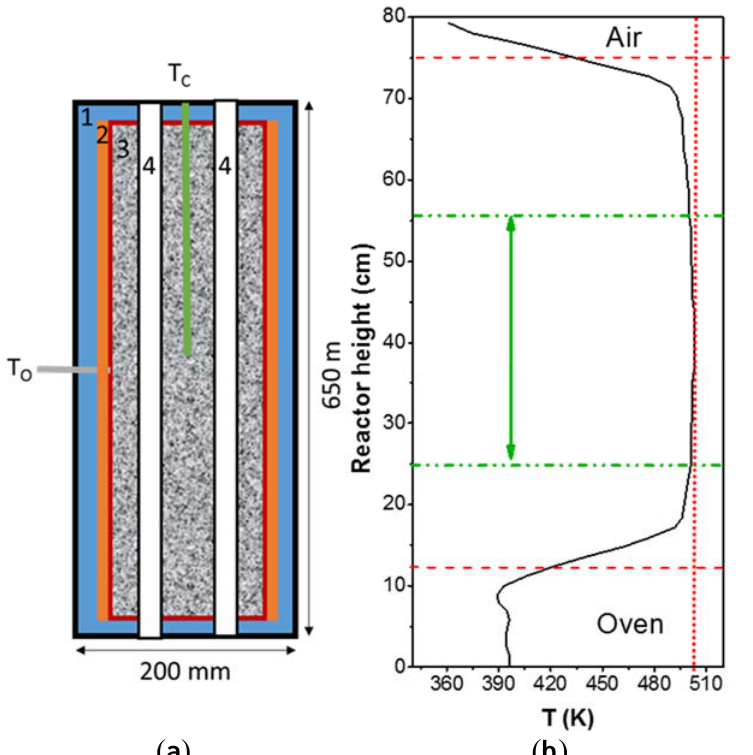
Figure 4. ( a ) Schematic representation of a reactor block of the HTK-S set-up (1. insulation, 2. Electrical heating, 3. SiC, 4. reactor well, T C : central thermocouple; T O : thermocouple located near the heating elements) and ( b ) axial temperature profile measured in the absence of reaction (setpoint: 203 K); isothermal zone indicated in green ( Δ T < 1